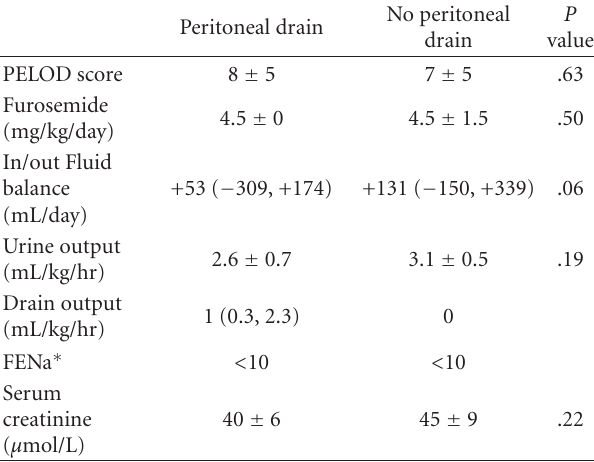
Table 1: E ff ect of the peritoneal drain on fluid balance after cardiac surgery. During the week preceding and following peritoneal drain removal we report the clinical severity data (PELOD score), diuretic therapy, parameters of the fluid balance, and renal function. Data were compared with the bilateral student T test. P -value < .05 was considered statistically